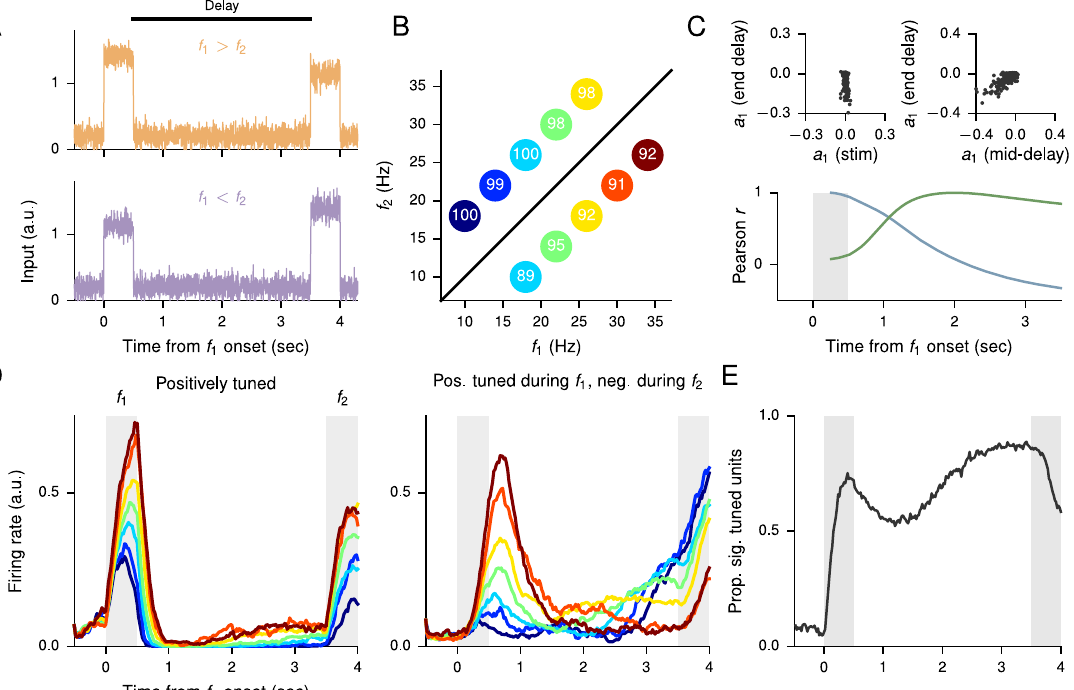
Fig 7. Parametric working memory task. (A) Sample positively tuned inputs, showing the case where f 1 > f 2 (upper) and f 1 < f 2 (lower). Recurrent units also receive corresponding negatively tuned inputs. (B) Percentage of correct responses for different combinations of f 1 and f 2 . This plot also defines the colors used for each condition, labeled by f 1 , in the remainder of the figure. Due to the overlap in the values of f 1 , there are 7 distinct colors representing 10 trial conditions. (C) Lower: Correlation of the tuning a 1 (see text) at different time points to the tuning in the middle of the first stimulus period (blue) and middle of the delay period (green). Upper: The tuning at the end of delay vs. middle of the first stimulus (left) and the end of delay vs. middle of the delay (right). (D) Single-unit activity for a unit that is positively tuned for f 1 during both stimulus periods (left), and for a unit that is positively tuned during the first stimulus period but negatively tuned during the second stimulus period (right). (E) Proportion of significantly tuned units based on a simple linear regression of the firing rates as a function of f 1 at each time point.